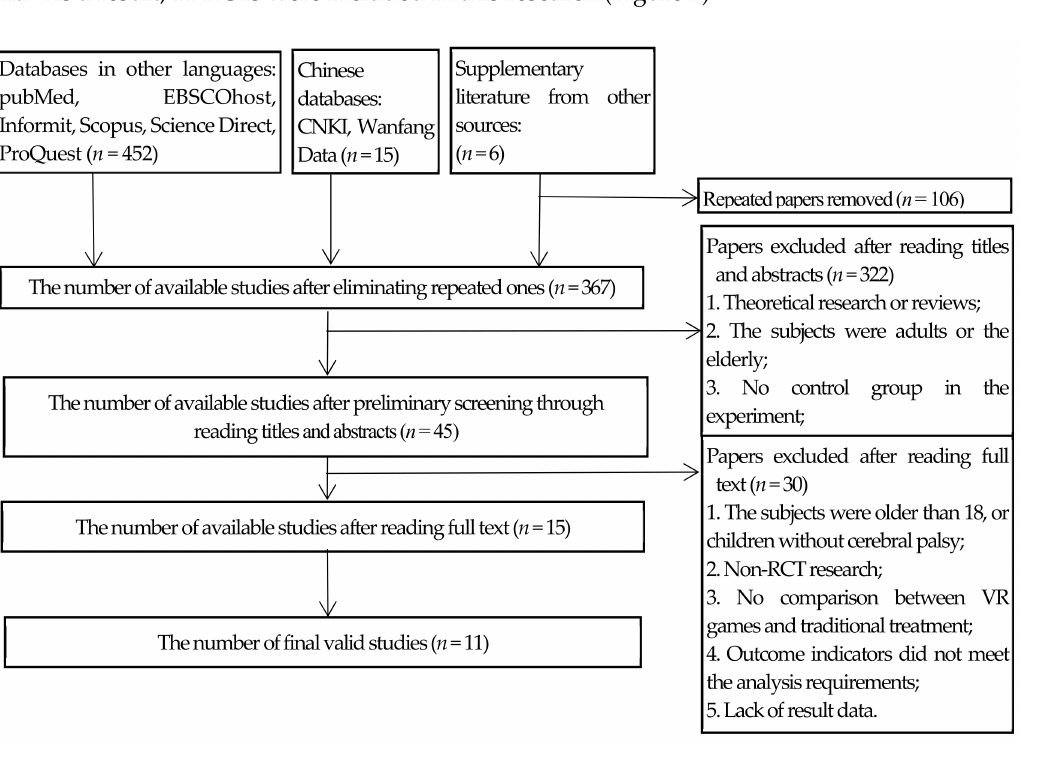
Figure 1. The flow chart of literature